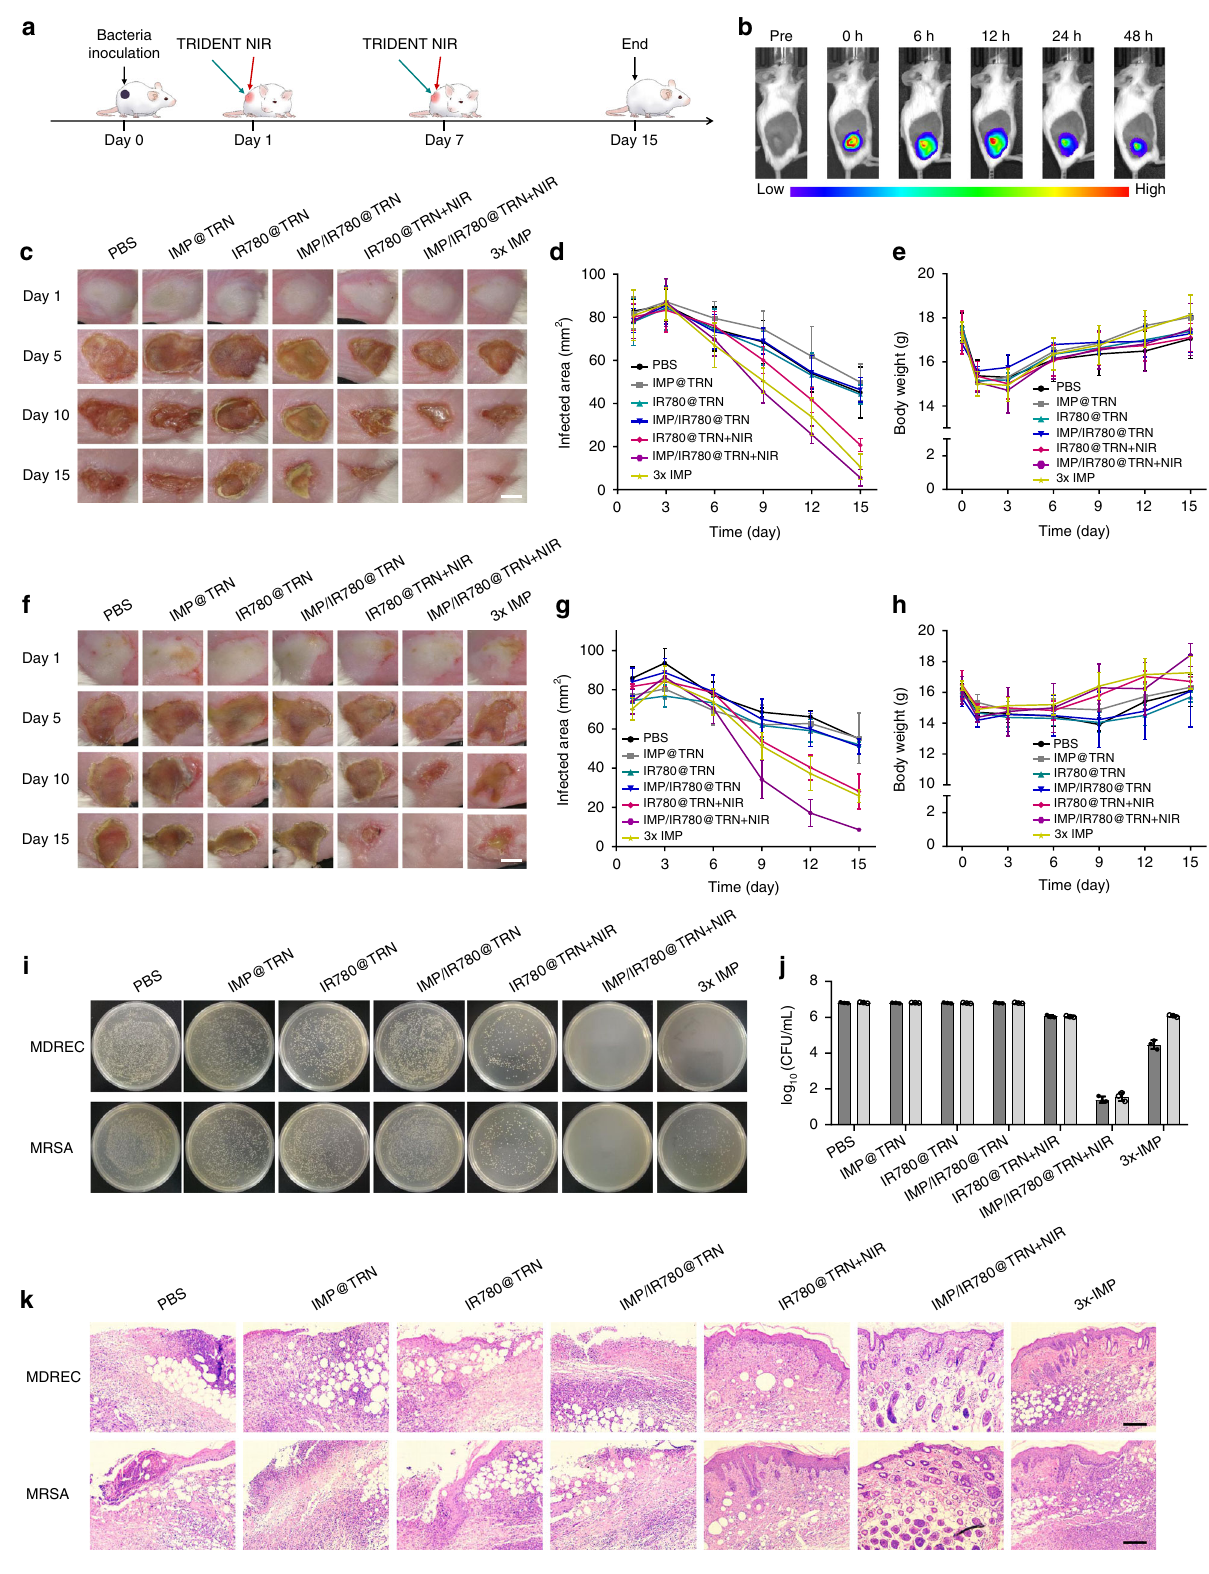
NIR-triggered nanomaterial complex (TRIDENT) for effective bacterial killing with three functions. Firstly, fl uorescent IR780 molecules enable real-time monitoring of the amount of the complex at the infection site, guiding the use of NIR irradiation at